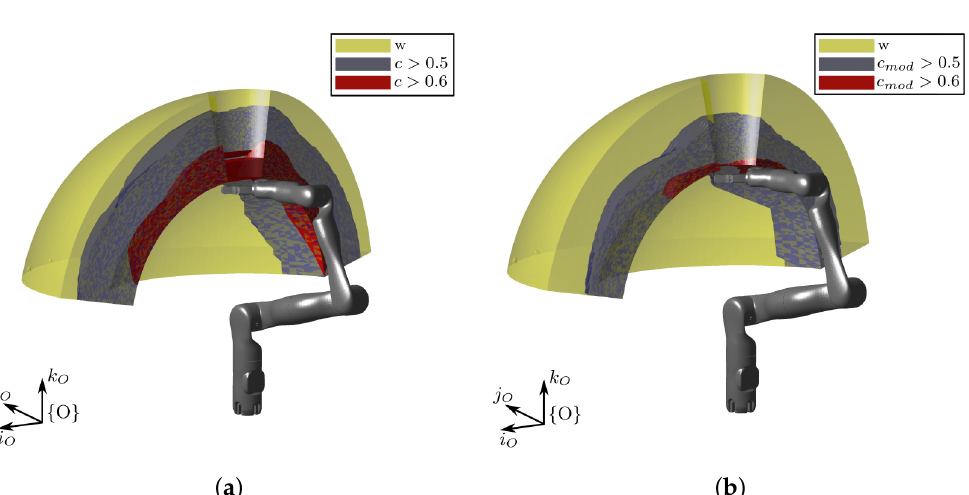
Figure 6. ( a ) Manipulability map for the Kinova Gen2 7 d.o.f. arm in terms of c , ( b ) Manipulability map for the Kinova Gen2 7 d.o.f. arm in terms of c mod . The position and orientation of the end-effector during the mapping process is showed in both figures. w is the total explored workspace, c and c mod are the 2-norm condition number and the modified version of it, respectively, as presented in Equations (21) and (26).